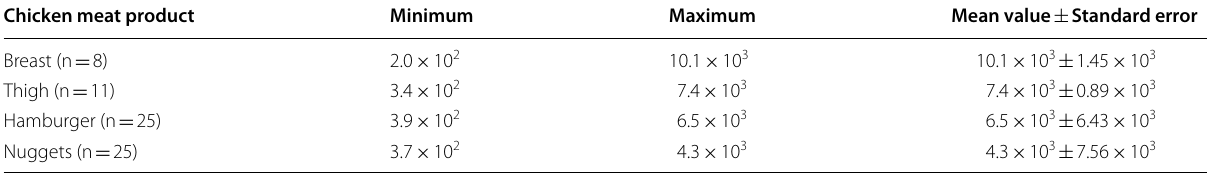
Table 2 The mean values of colony forming units (CFU/g) for 69 Pseudomonas spp. detected in chicken meat products Chicken meat product